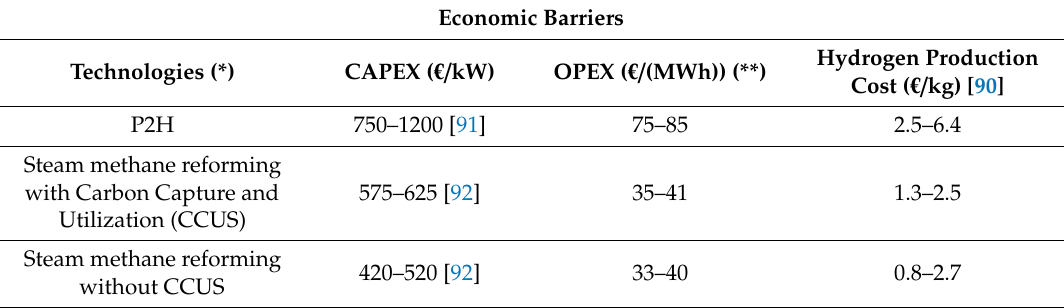
Table 1. Economic barriers. Capital Expenditure (CAPEX) and Operative Expenditure (OPEX) are referred to by the unit of hydrogen produced (kg).